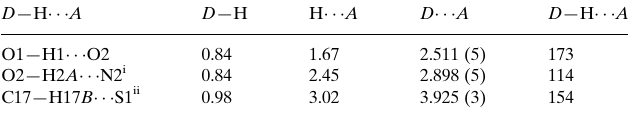
Hydrogen-bond geometry (A˚ , (cid:3)